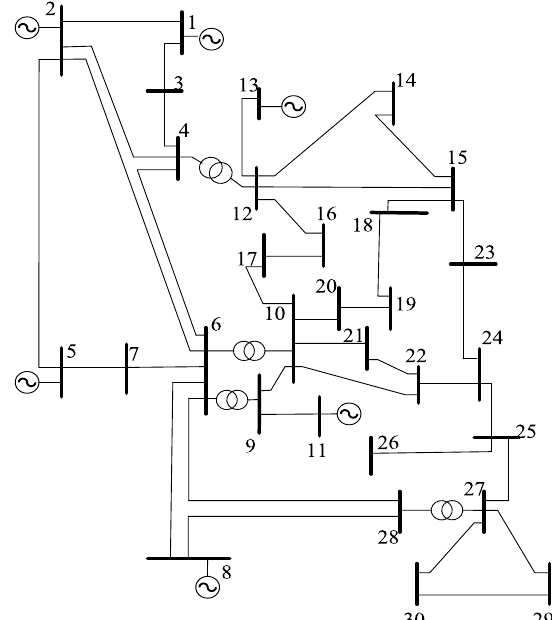
Fig. 4 Line diagram of the IEEE 30-bus test system